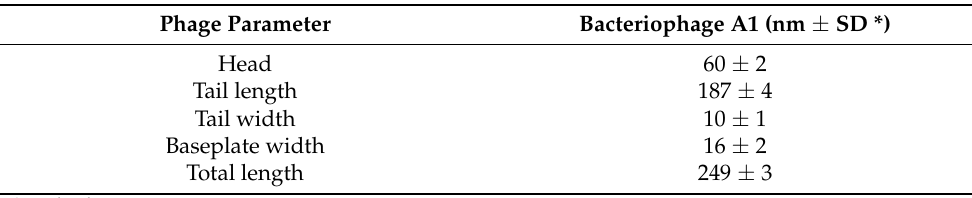
Table 2. Phage A1